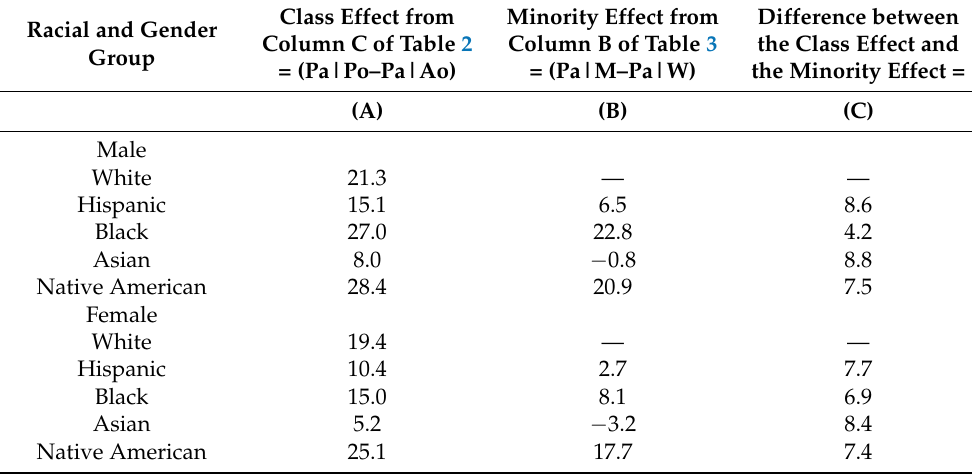
Table 4. Comparing the Effects of Class Origins with Racial Minority Effects by Gender in Becoming a Poor Adult as Derived from Results of Chetty et al.